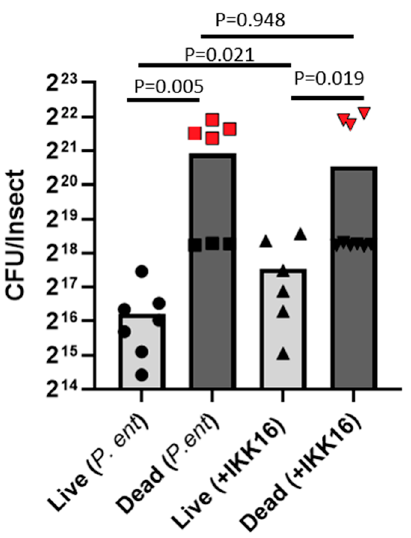
Figure 6. Pseudomonas entomophila load during in vivo infection. Adult bed bugs were fed a blood meal containing P. entomophila with or without 10 ug/mL of IKK16 added. At 24 h post-feeding, living and dead insects were surface sterilized, homogenized and plated on LB agar to estimate the load of P. entomophila (expressed as CFU/insect). Shown are individual data points derived from 2 independent biological replicates and their mean. Bacterial loads were compared using ANOVA with adjustment for multiple comparisons. Red data points indicate insects suspected of having experienced post-mortem bacterial replication which were excluded from the statistical analysis.